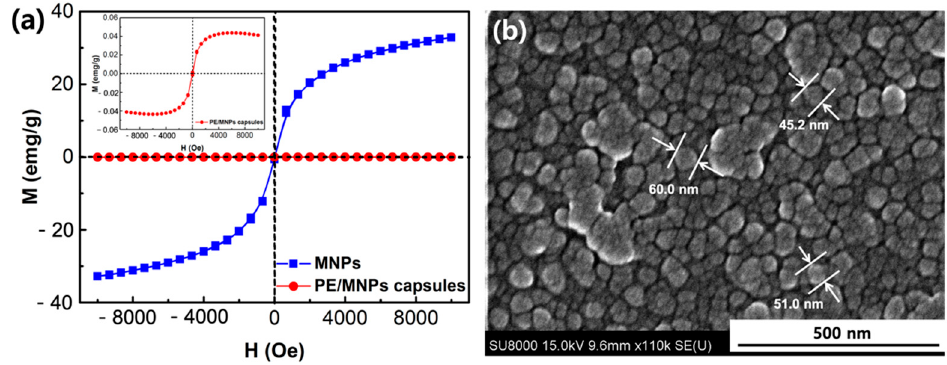
Figure 5. ( a ) Hysteresis curve of MNPs and PE/MNPs microcapsules. ( b ) SEM image of MNPs.